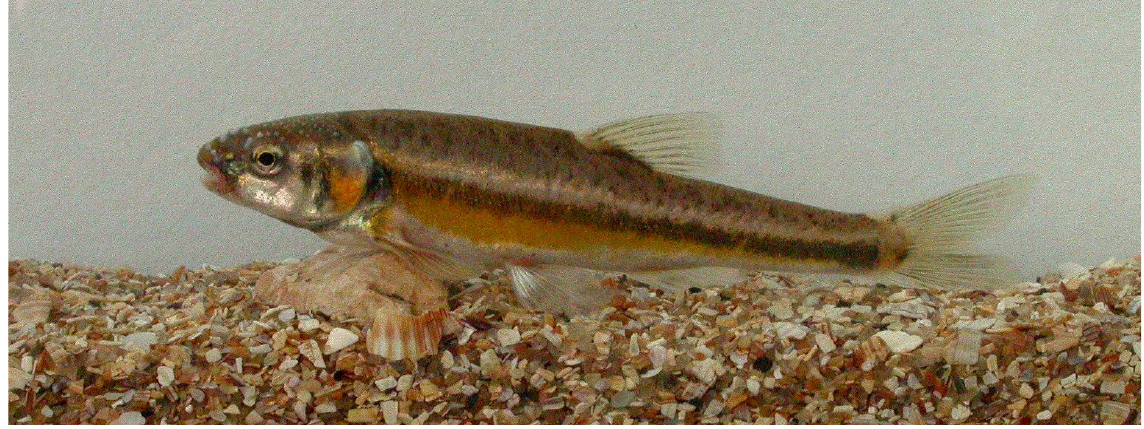
Fig. 6. Phoxinus chrysoprasius (Pallas, 1814), living specimen, spawning male, Angara River, Salhir drainage, 44°51ʹ12ʺ N, 34°18ʹ47ʺ E; 16 Jun.